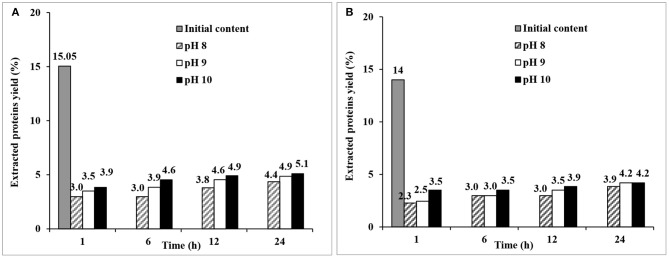
Protein extraction yield from (A) fine and (B) coarse de-starched wheat bran at 25°C, at three different pHs (8, 9, 10) and at four residence times (1, 6, 12, and 24 h). The figure shows single experiments.